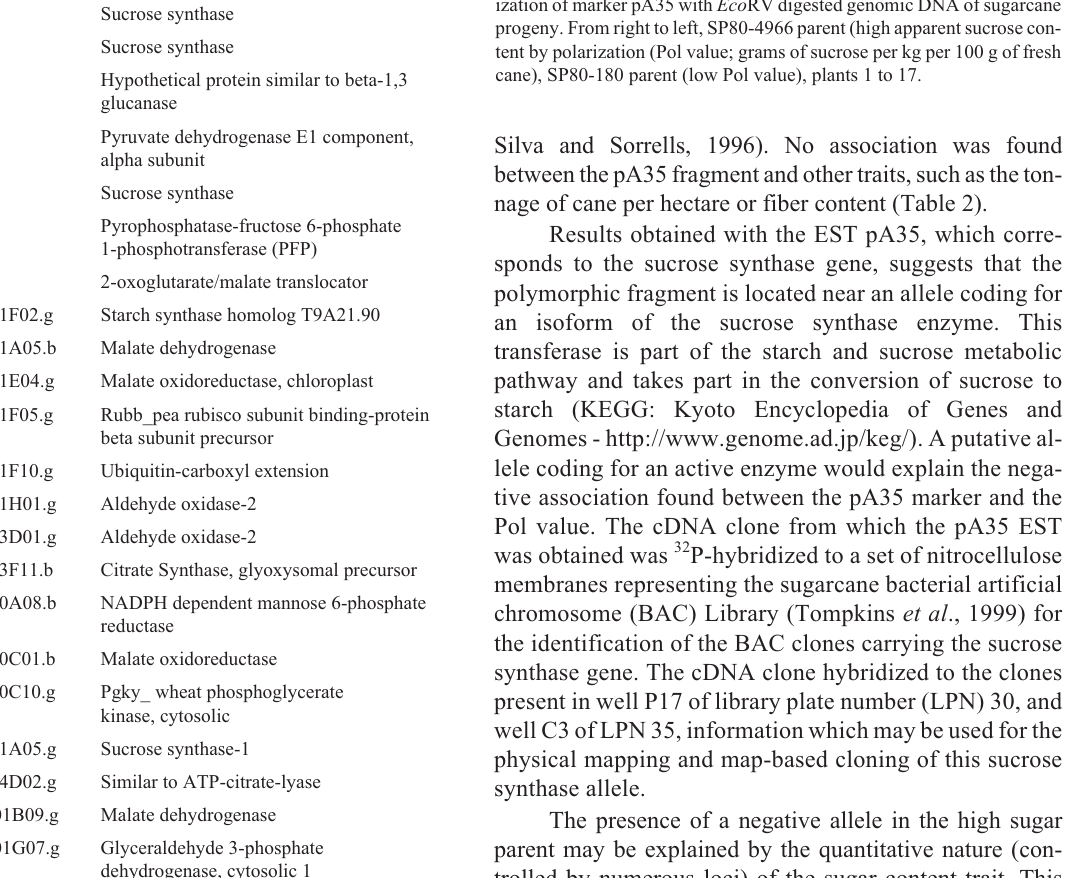
Figure 1 - Single dose restriction fragment generated by southern hybrid- ization of marker pA35 with Eco RV digested genomic DNA of